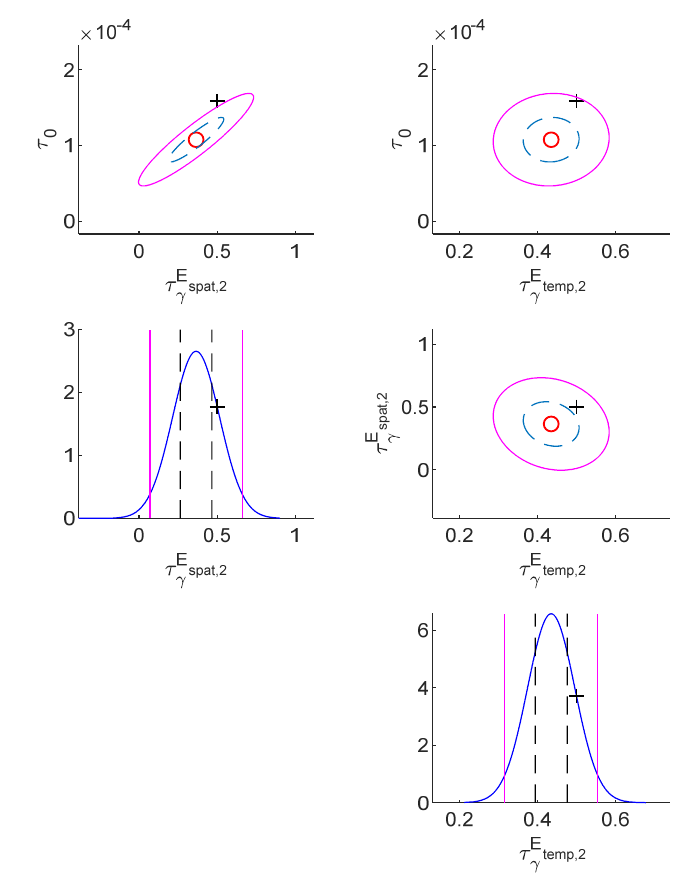
Figure 4. Contour plot of the posterior PDF of the measurement error parameters of the most plausible model (damaged case).